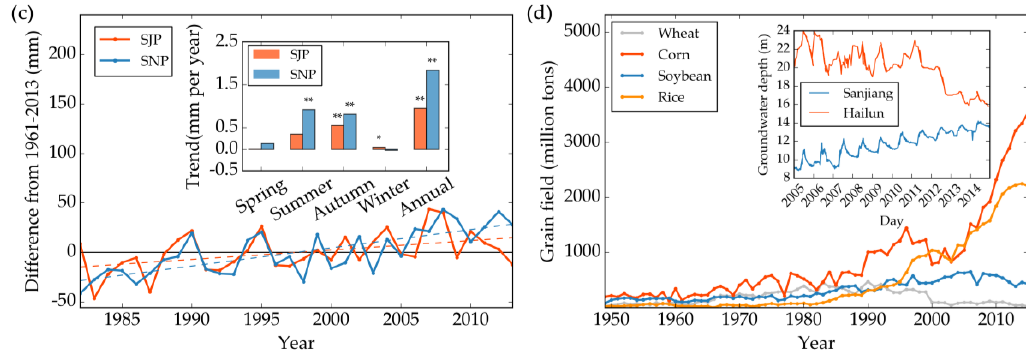
Figure 5. The observed trends of hydro-meteorological variables, variations of groundwater depth and changes in grain yields in the Heilongjiang Province. ( a ) the variations of annual mean air temperature observed between 1961 and 2013 over the SJP (in orange yellow color) and SNP (in light blue color), expressed as deviation from the mean during that period (in line). The dotted line is a fit to the data. The inset displayed trends in seasonal temperature ( ◦ C per year) during the period 1961–2013. A p value of <0.05 was taken as statistically significant. Levels of significance were denoted as: * 0.01 < p < 0.05, ** p < 0.01; ( b , c ) Same as ( a ) but for precipitation (1961–2013) and evapotranspiration (1982–2013)